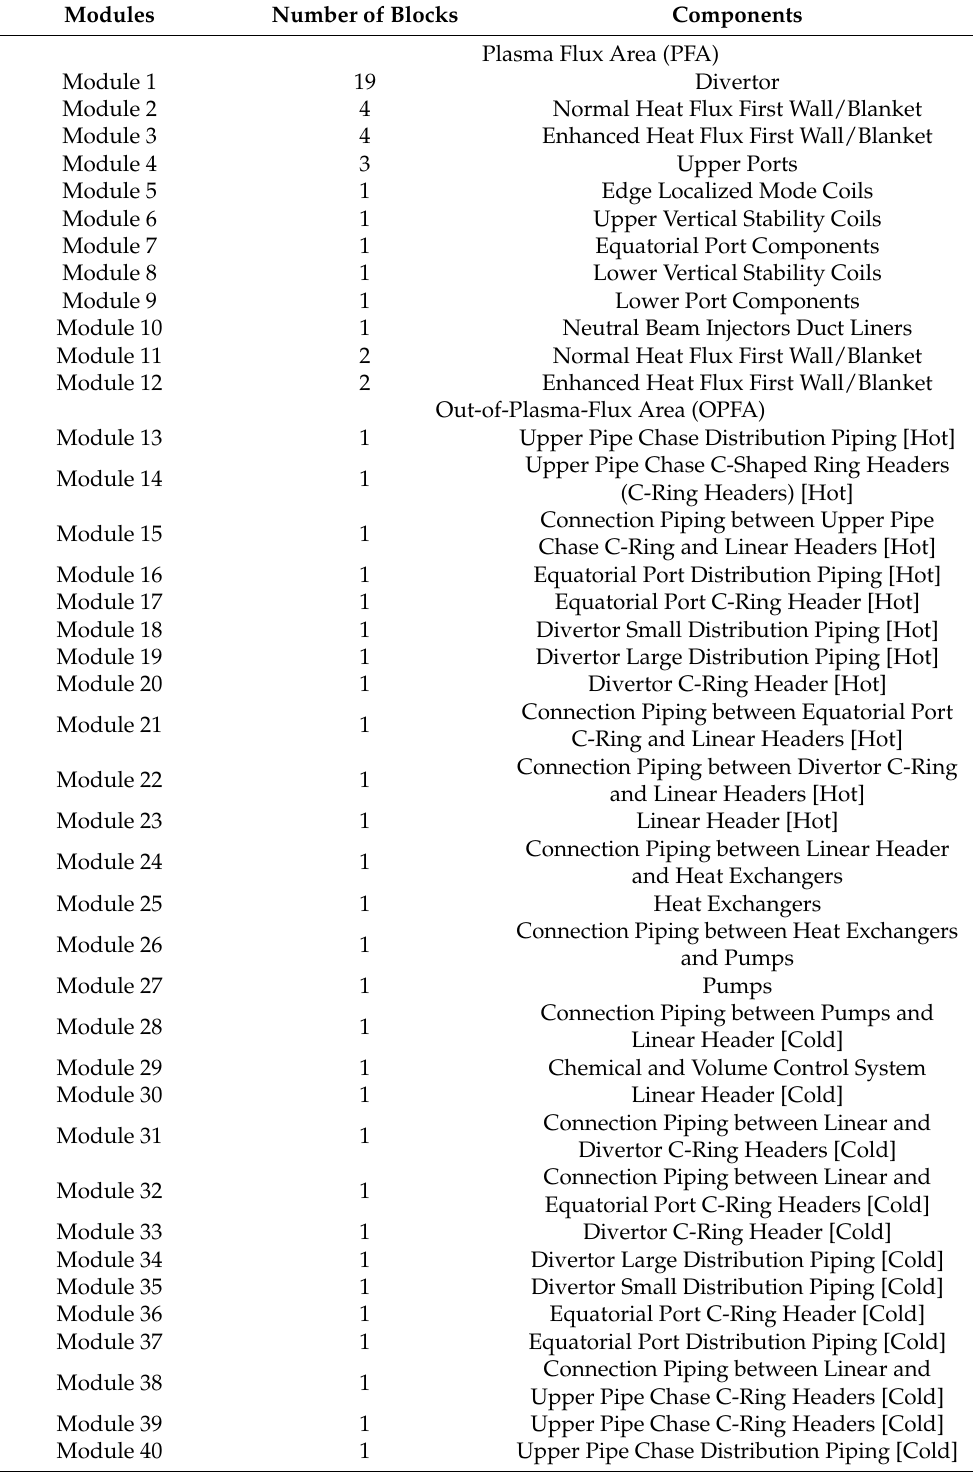
Table 20. List of IBED PHTS Modules for Radiolysis Simulation